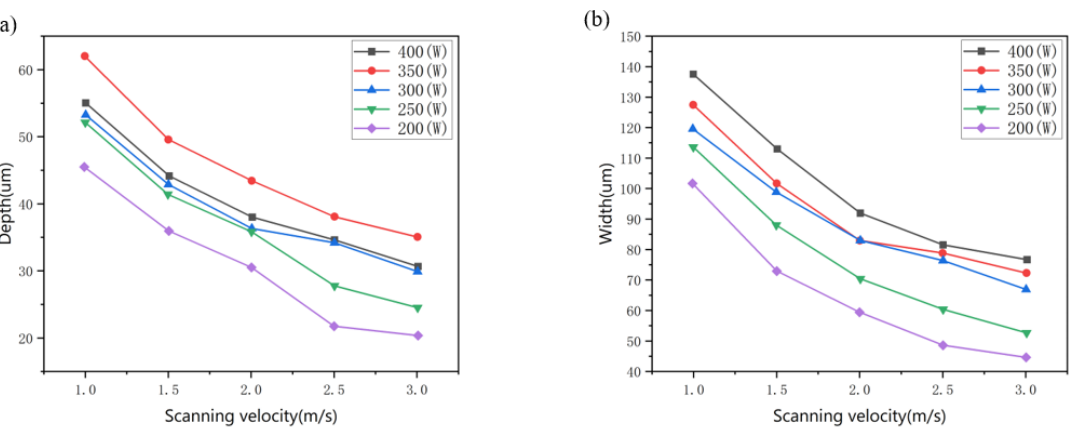
Figure 9. Geometry change of the melt pool characterized by the depth ( a ) and width ( b ) with different laser power and scanning velocity.